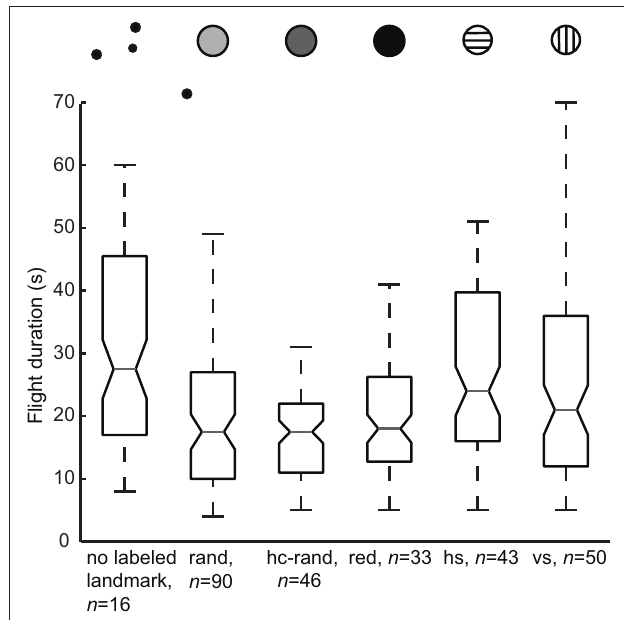
Figure 2 | Navigational performance with different landmark textures. The search time was measured from the moment a bee entered the arena until it landed on the feeder. This time is an indicator of the bee’s navigational performance. The box plots allow us to compare the median flight duration for all training flights between the different conditions: with no labeled landmark (all cylinders have a homogenous red texture, n = 16, N = 6) and with a labeled landmark, where the cylinder closest to the feeder has a unique texture [random dot pattern (rand, n = 90, N = 20), high-contrast random dot pattern (hc rand, n = 46, N = 10), red homogenous texture (red, n = 33, N = 8), horizontal (hs, n = 43, N = 10) and vertical (vs, n = 50, N = 9) stripe patterns]. The central mark is the median; the edges of the box are the 25th and 75th percentiles. The plotted whisker extends to the adjacent value, which is the most extreme data value that is not an outlier. Outliers (any data point more than 1.5 × IQR (interquartile range) lower than the first quartile or 1.5 × IQR higher than the third quartile) are not shown. The width of the notches is computed in such a way that the box plots, whose notches do not